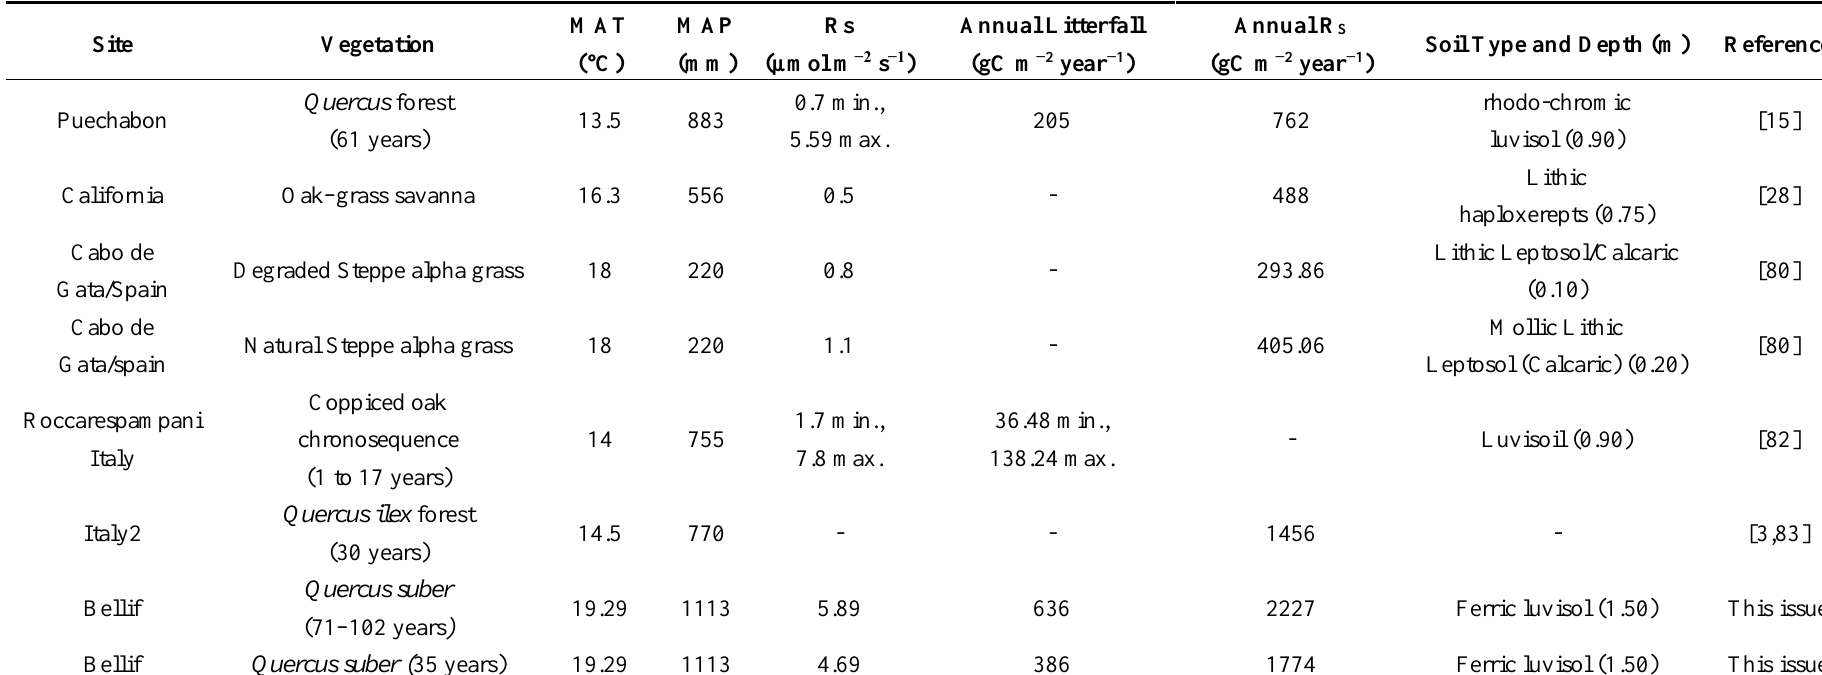
Table 3. Review of annual respiration rates measured in the Mediterranean region, including forest type, mean annual air temperature (MAT), mean annual precipitation (MAP), annual litterfall, annual soil respiration (R s ), and soil type and